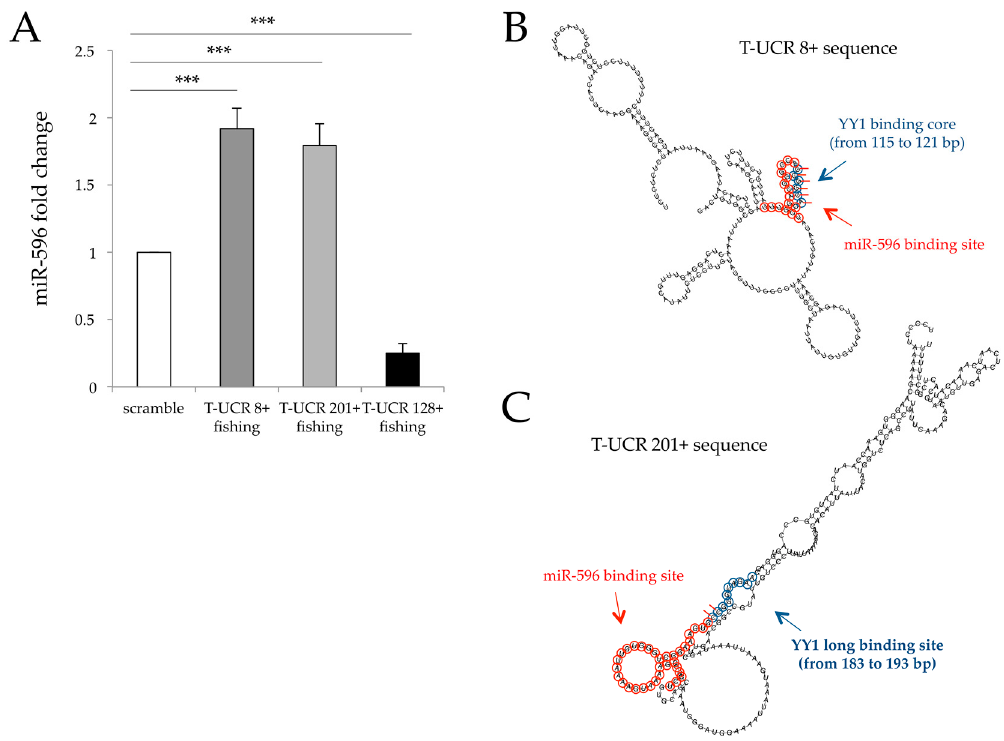
Figure 2. miR-596::T-UCR 8+/201+ binding, T-UCR 8+/201+ secondary structure and miR-596 and YY1 binding site. ( A ) Real-time PCRs and fold change of miR-596 pull down with peptide nucleic acid (PNA)/T-UCR 8+, (PNA)/T-UCR 201+ and (PNA)/T-UCR 128+ in J82 cancer cell line; ( B ) Predicted RNA secondary structure of T-UCR 8+ with miR-596 (circles in red) and YY1 (circles in blue) binding site. The short red lines indicate regions in which both miR-596 and YY1 bind T-UCR 8+ sequence; ( C ) Predicted RNA secondary structure of T-UCR 201+ with miR-596 (circles in red) and YY1 (circles in blue) binding site. The short red lines indicate regions in which both miR-596 and YY1 bind T-UCR 201+ sequence. Scramble value is considered equal to 1. Data are expressed as the mean ± SD of triplicate values. p values were obtained using the Student t -test for three independent samples. *** p < 0.001 vs. control.